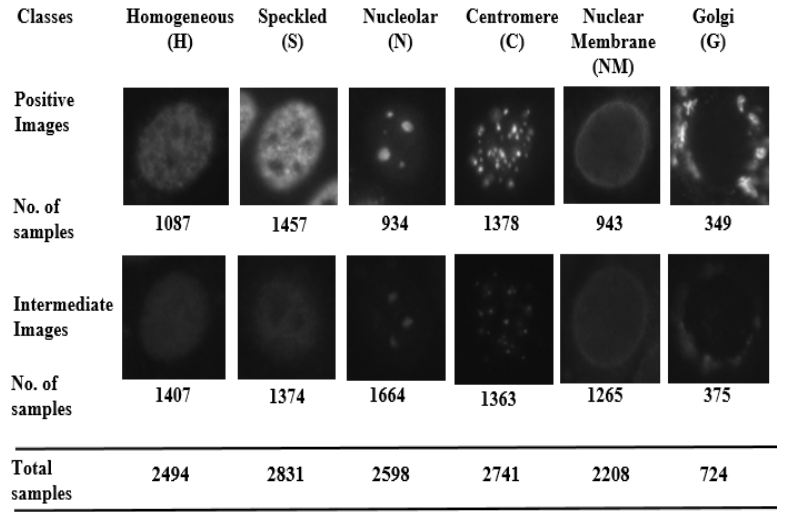
Figure 5. Sample images (Positive and Intermediate) and number of examples of each class in